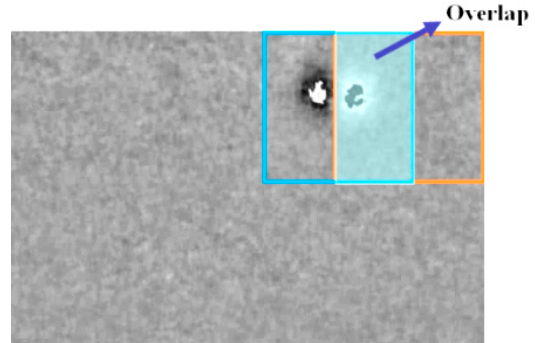
Figure 7. The abstract depiction of the sliding window indicating the overlap.